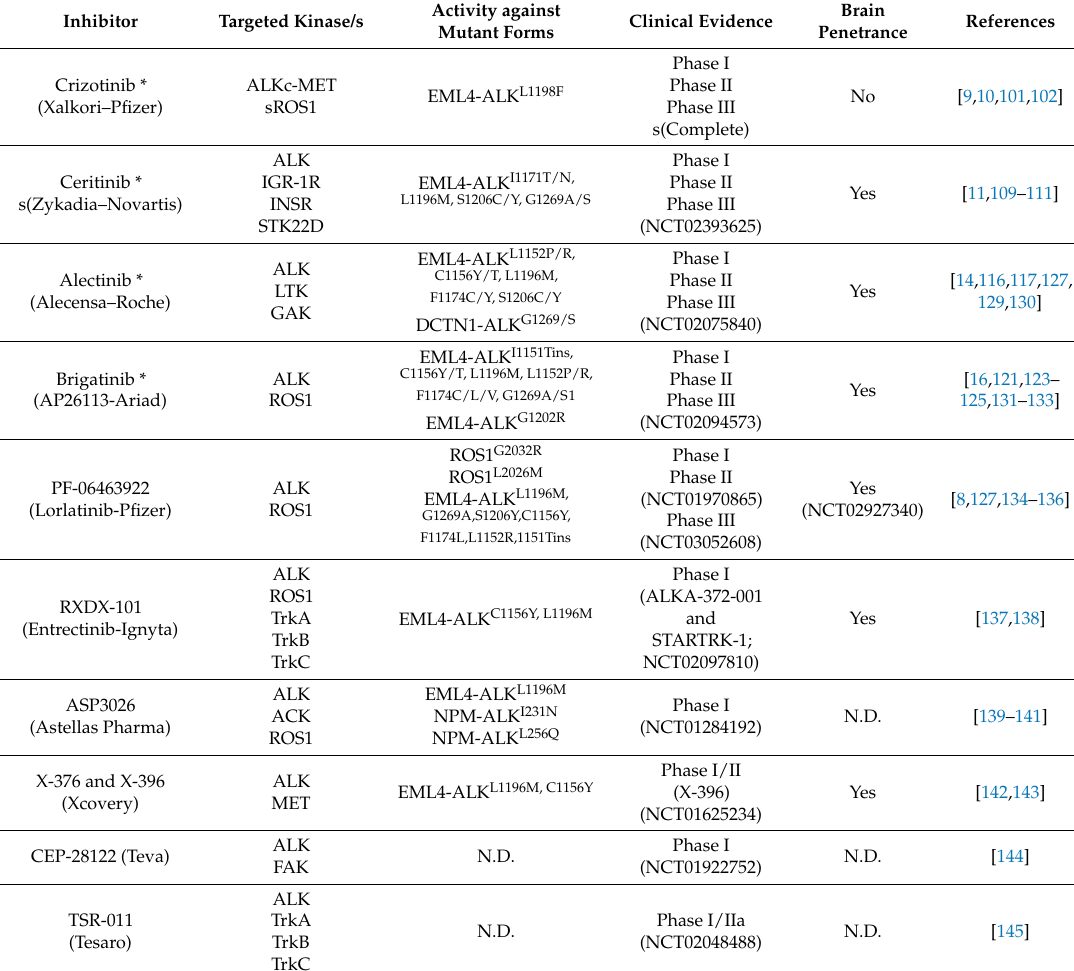
Table 2. FDA Approved and new ALK inhibitors under